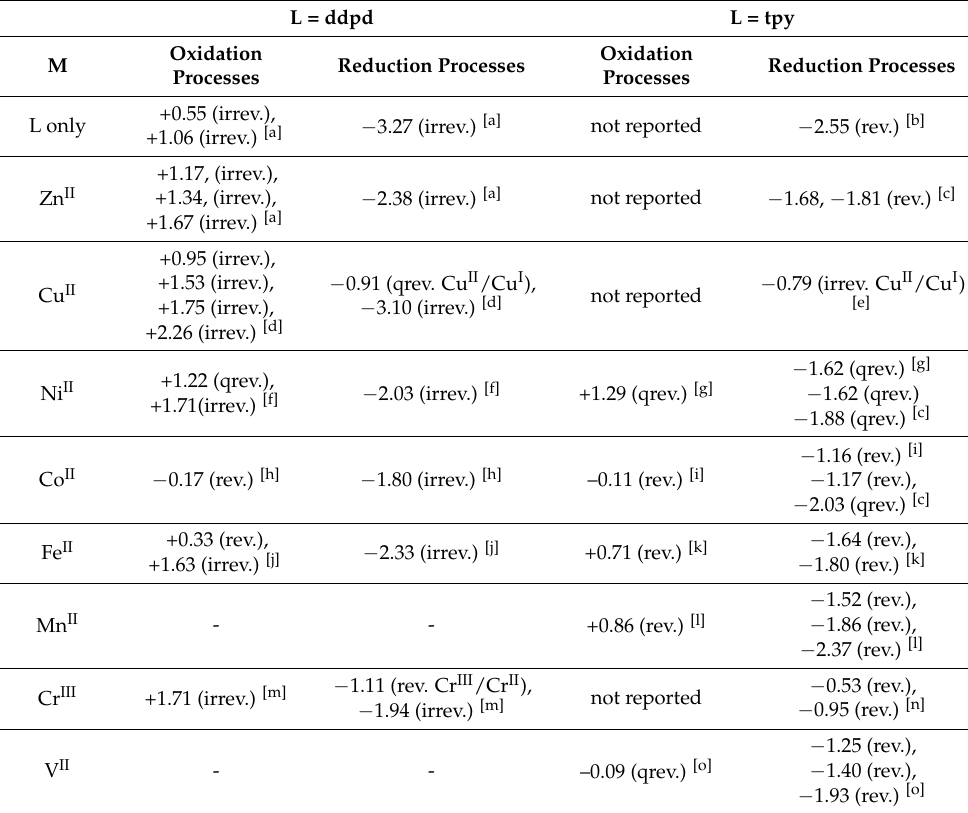
Table 4. Electrochemical data of [M(L) 2 ] n + complexes (L = ddpd, tpy; M = Zn II , Cu II , Ni II , Co II , Fe II , Mn II , Cr III , V II ) in V vs. ferrocene/ferrocenium in CH 3 CN. L = ddpd L = tpy Oxidation Oxidation Reduction Processes M Processes